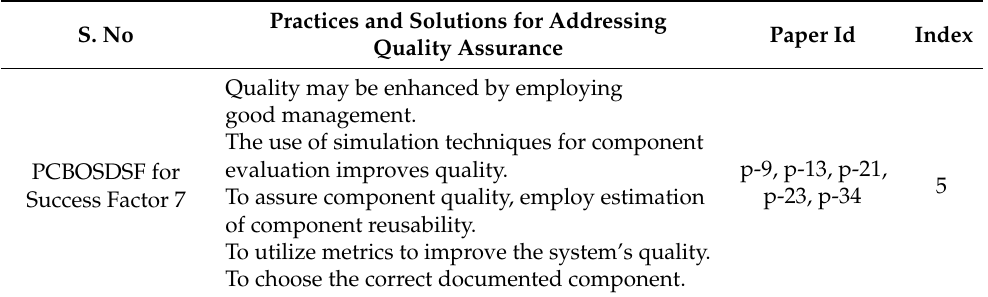
Table 11. CBOSDSF 7: Quality